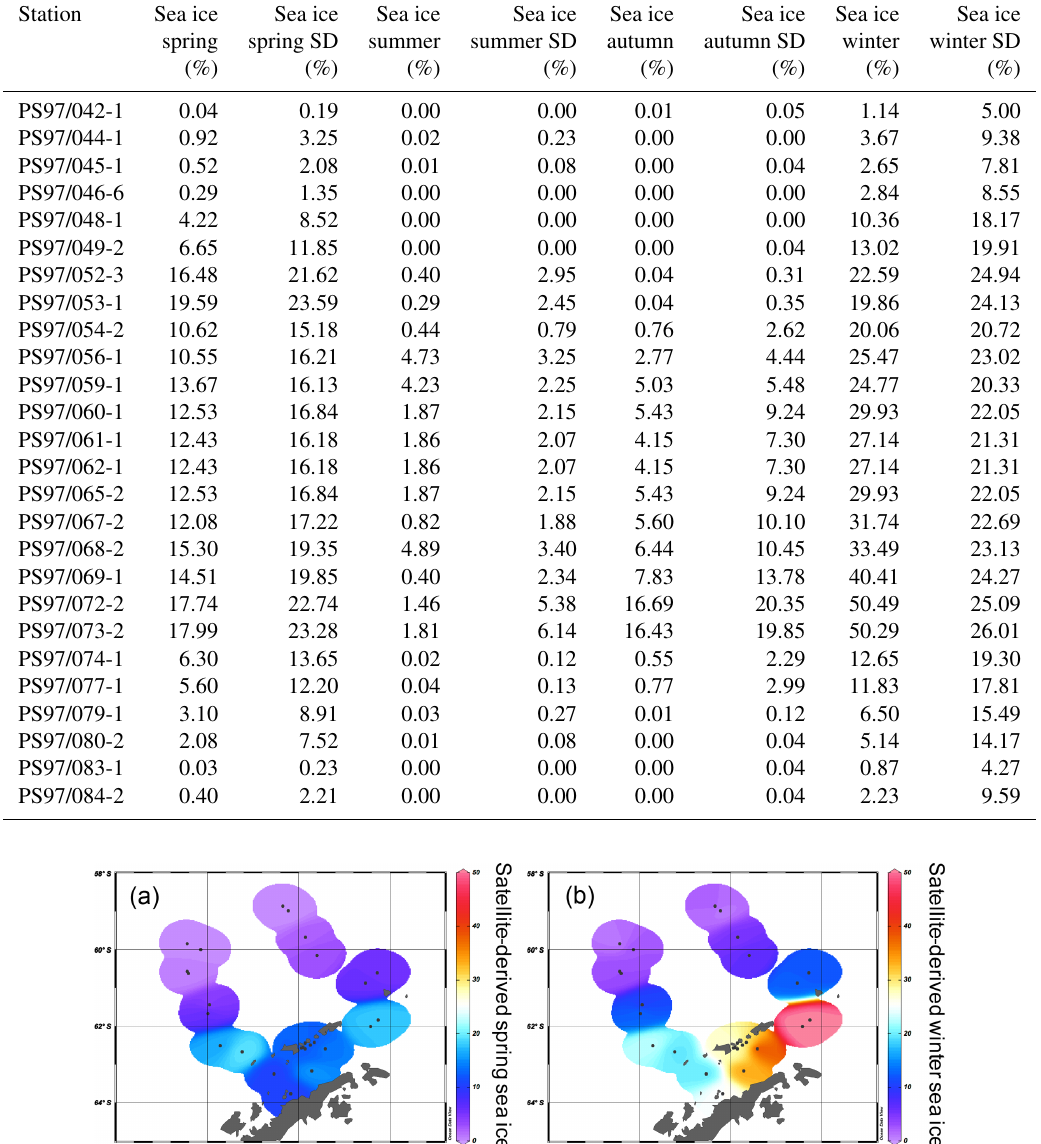
Table 2. Seasonal sea ice concentrations from satellite observations for spring, summer, autumn and winter, with standard deviations. Station Sea ice Sea ice